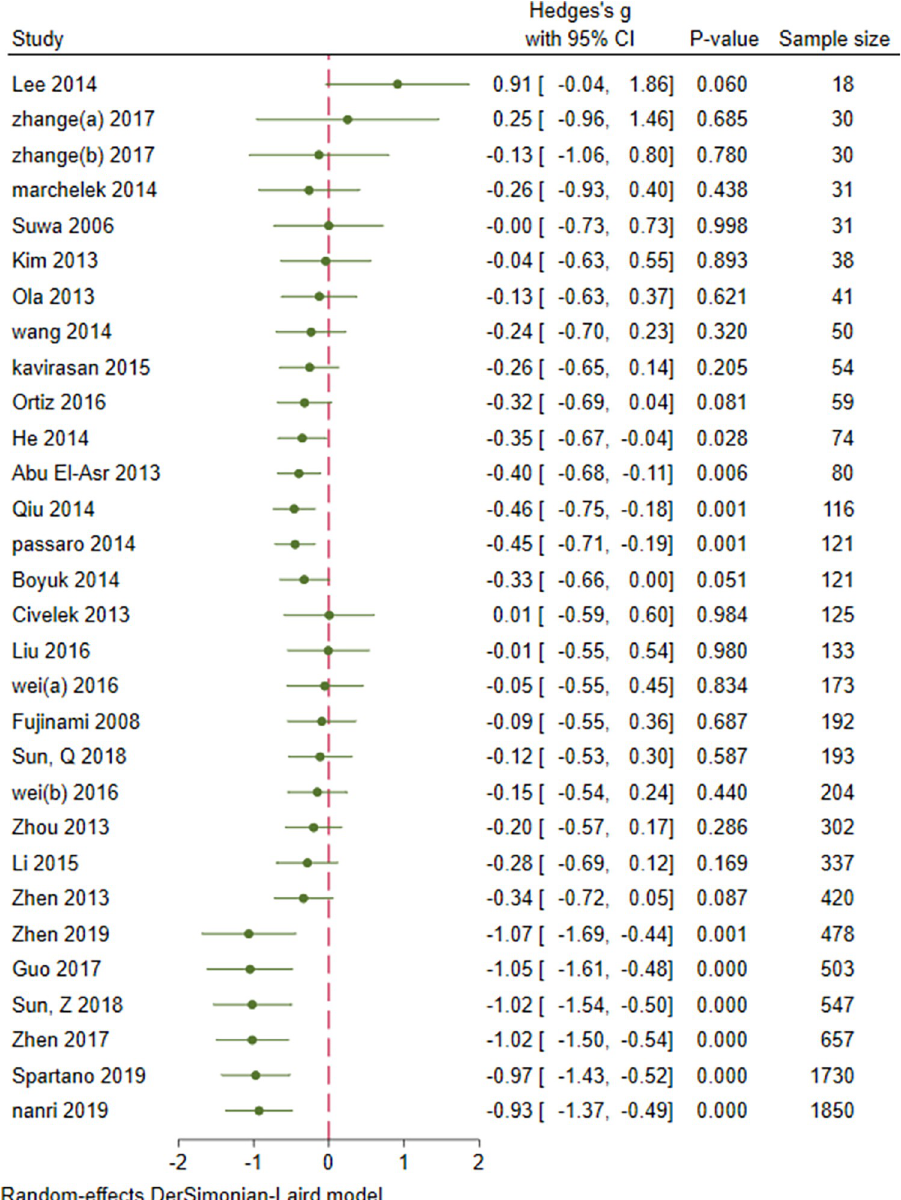
Fig 7. Cumulative meta-analysis of BDNF levels in patients with DM by sample